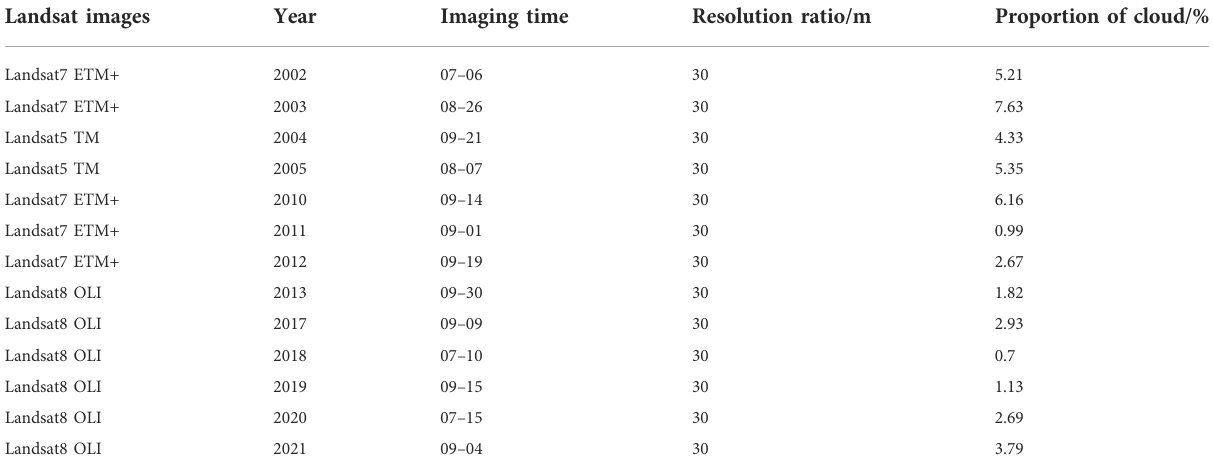
TABLE 1 Remote-sensing image